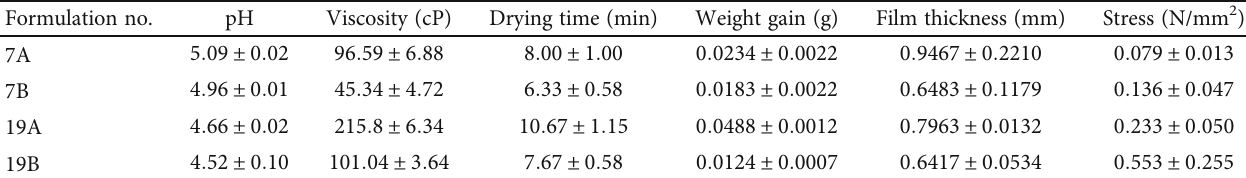
Table 4: Physicochemical and mechanical properties of developed nail lacquers containing bitter extract and copolymer. Formulation no.